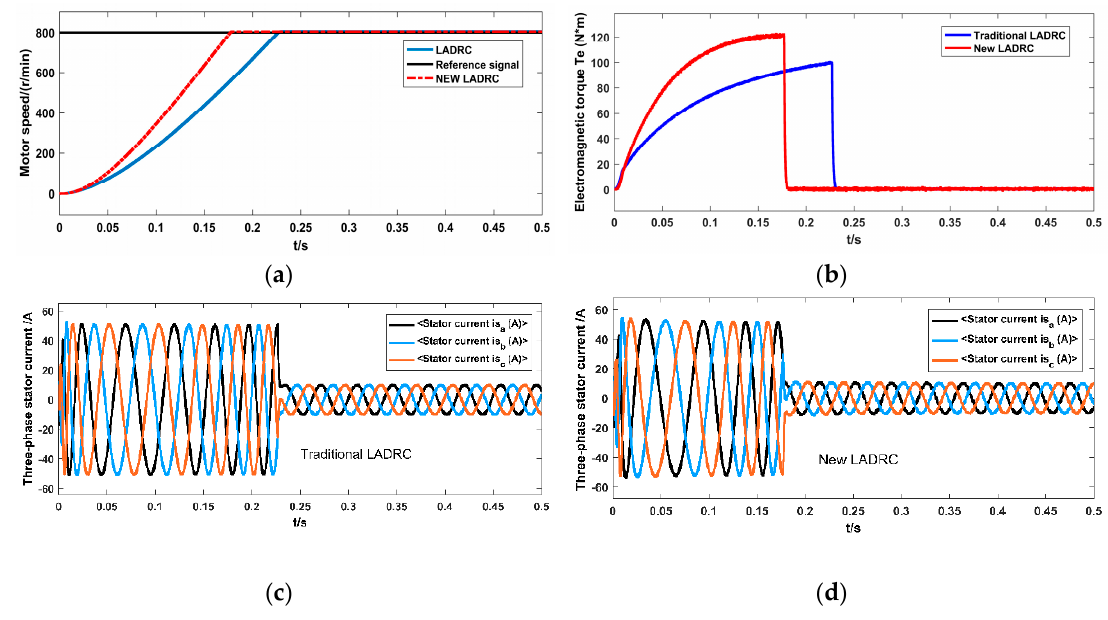
Figure 15. High-speed simulation of the asynchronous motor.